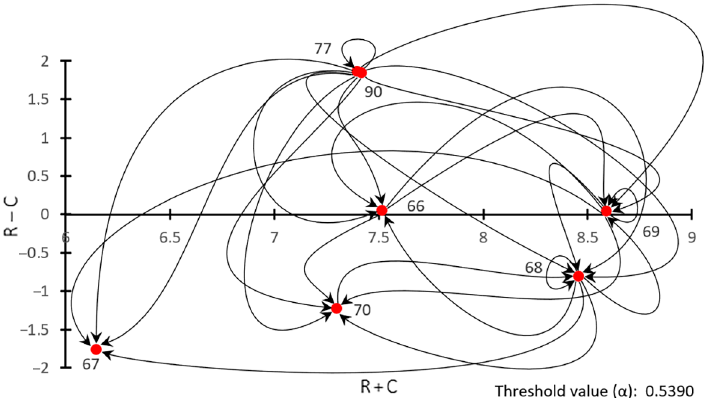
Figure 5. DEMATEL relationships diagram for C3 Processes